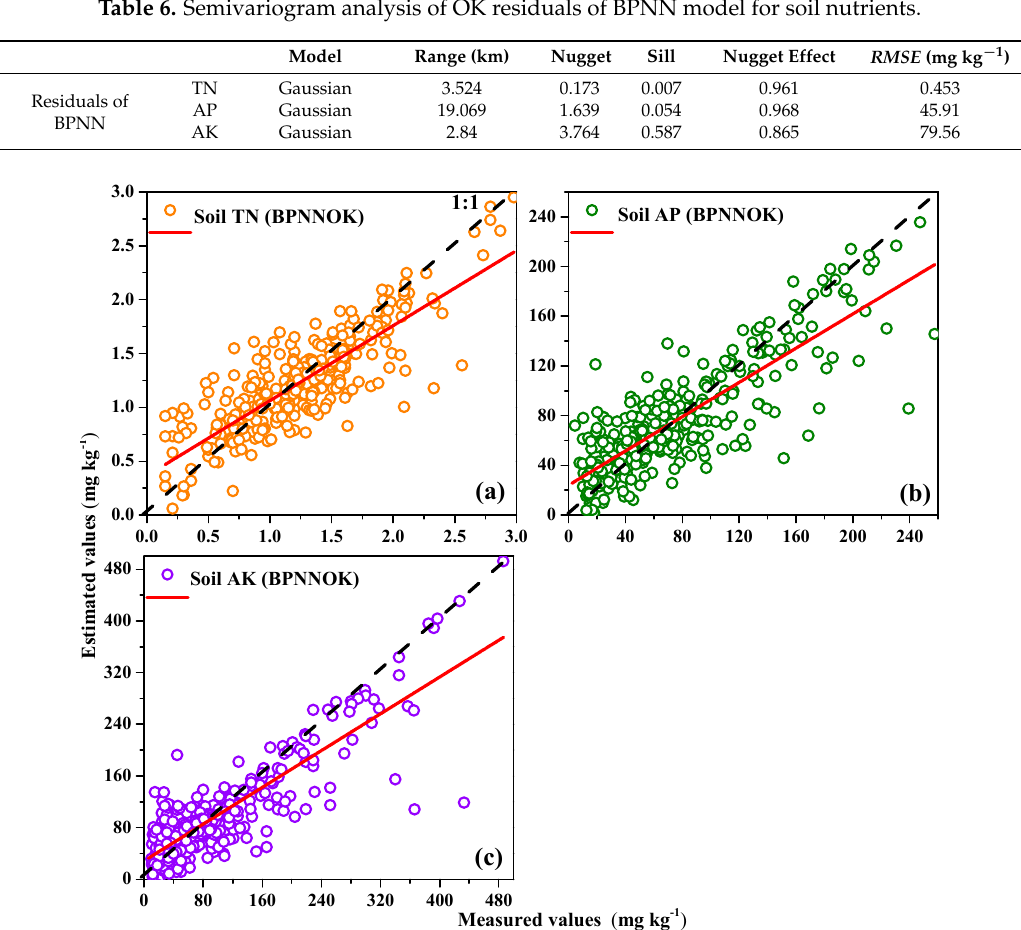
Figure 5. Measured values versus estimated values of ( a ) soil TN; ( b ) soil AP; and ( c ) soil AK, using BPNNOK model.